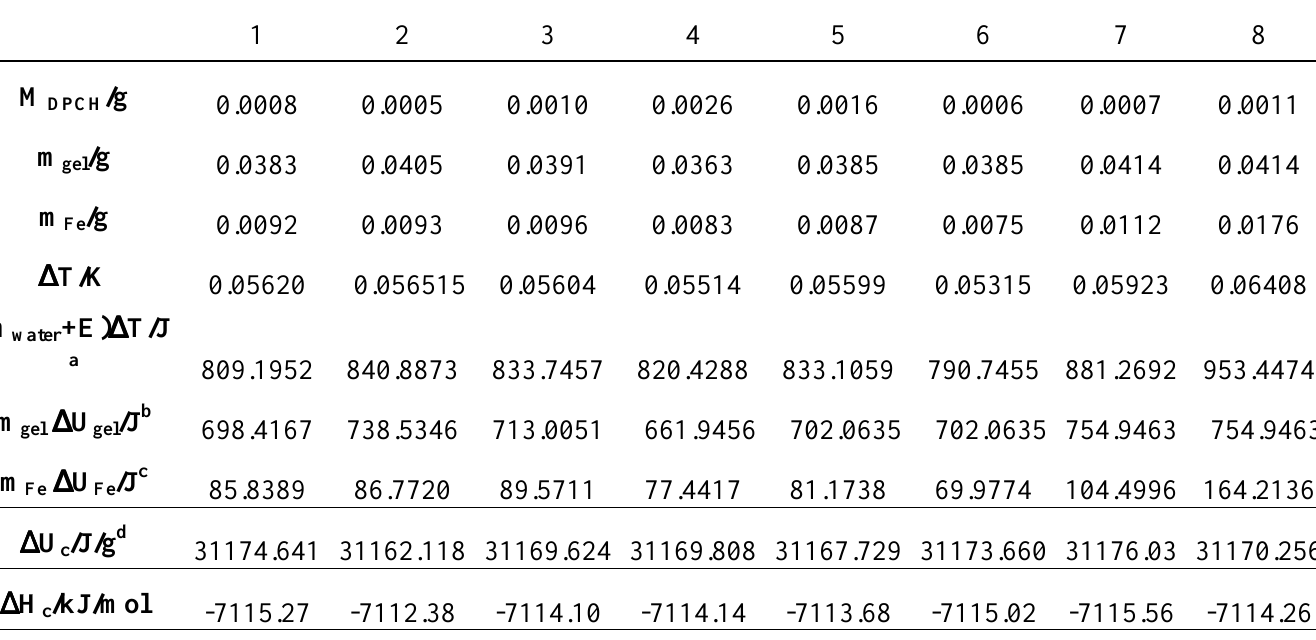
Table 1 . Results from typical combustion experiments at 298.15